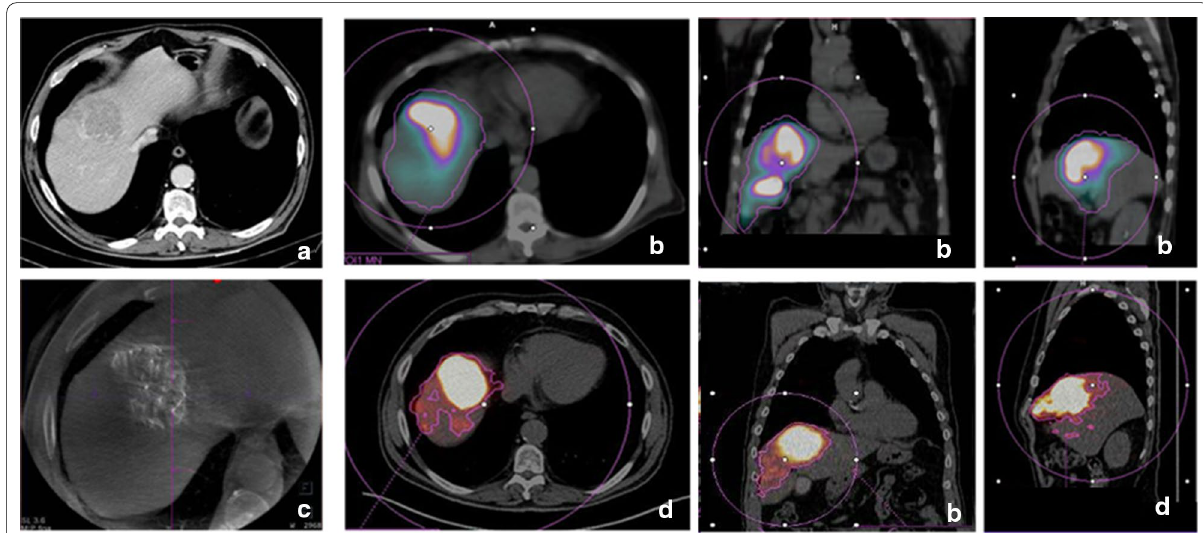
Fig. 1 a Contrast‑enhanced computed tomography (CECT) image in a patient with HCC located between segments IV and VIII. b Volumetric assessment of the target volume in SPECT/CT fusion images after the injection of 99m Tc‑MAA through IV and VIII segments arteries. The volume was obtained using a “volume of interest and isocontour” tool, drawn in purple. c C‑arm cone‑beam CT (CBCT) showing contrast uptake in the tumoral lesion with no perfusion in non‑tumoral parenchyma. d Volumetric assessment of the final target volume in the 90 Y PET/CT fusion